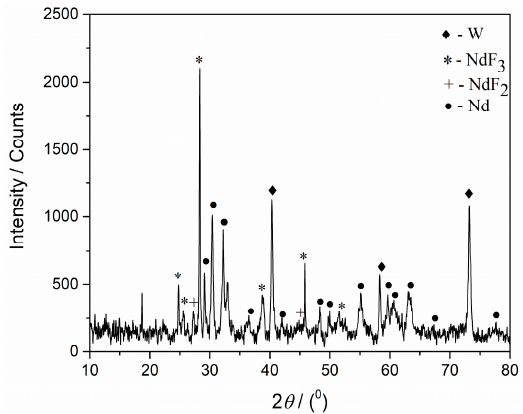
Figure 10. XRD spectra of the W working electrode surface after deposition at − 0.78 V for 7200 s, in molten NdF 3 –LiF–Nd 2 O 3 electrolyte system, at 1323 K (the solidified electrolyte was removed from the electrode and the W electrode was analyzed).